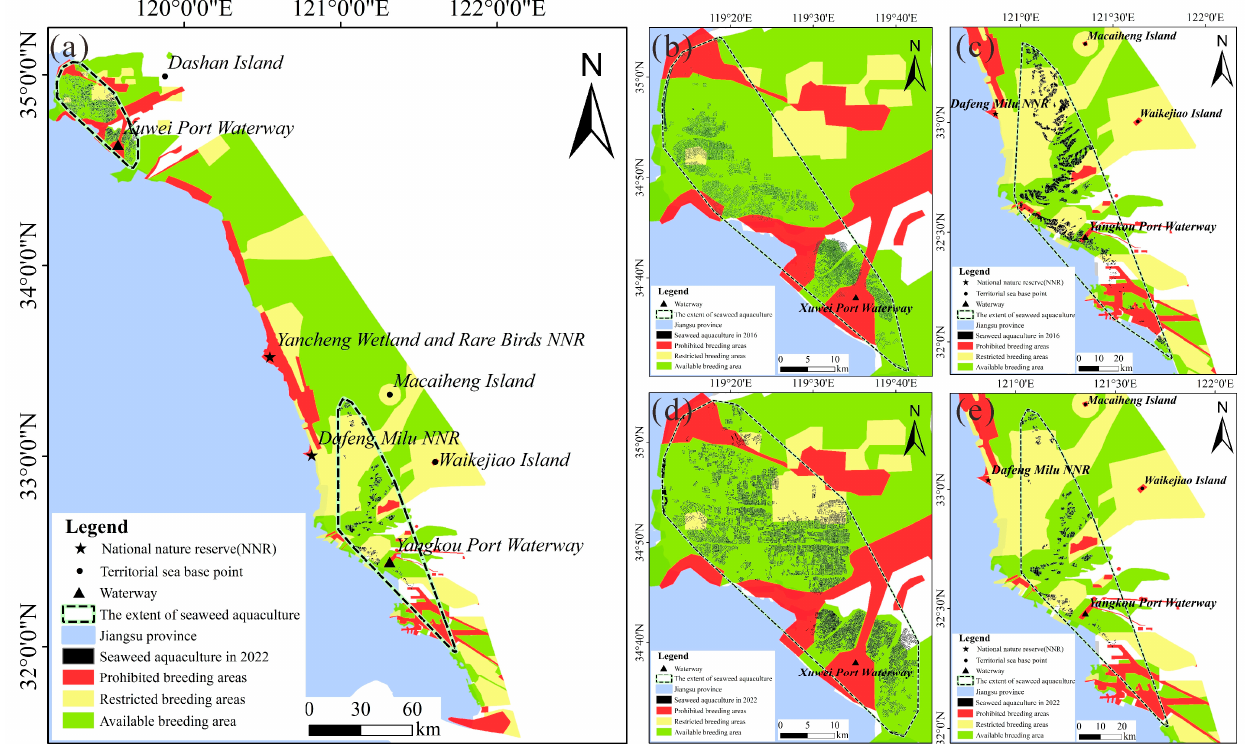
Figure 10. Distribution of unsustainable development of seaweed aquaculture (( a ): Seaweed farming in prohibited/restricted breeding areas in 2022; ( b , c ): Scope of Mode-I and Mode-II distributed in prohibited/restricted breeding areas in 2016; ( d , e ): Scope of Mode-I and Mode-II distributed in prohibited/restricted breeding areas in 2022).